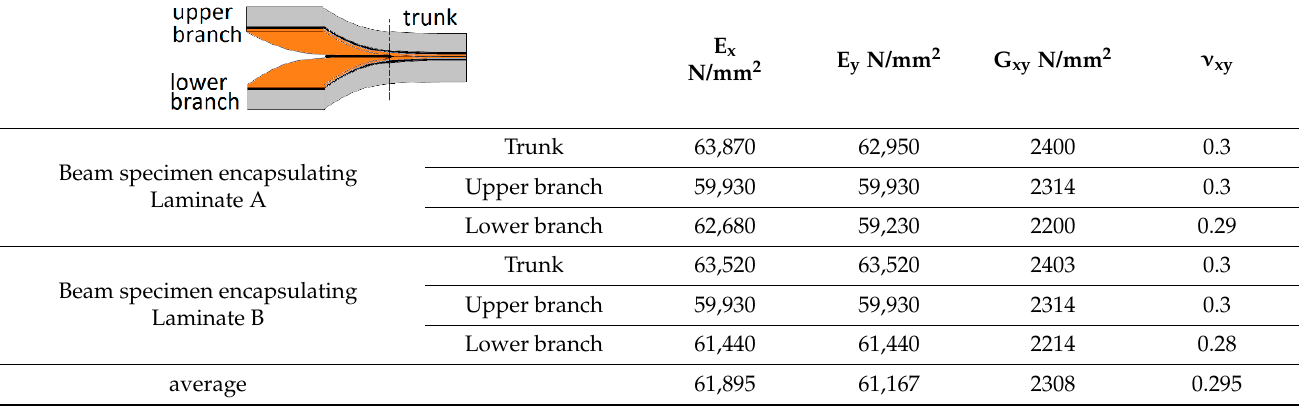
Table 2. Effective mechanical properties of specimens.